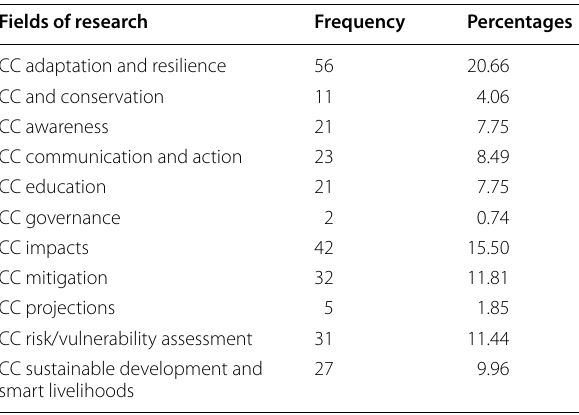
Table 2 Fields of research of participants Fields of